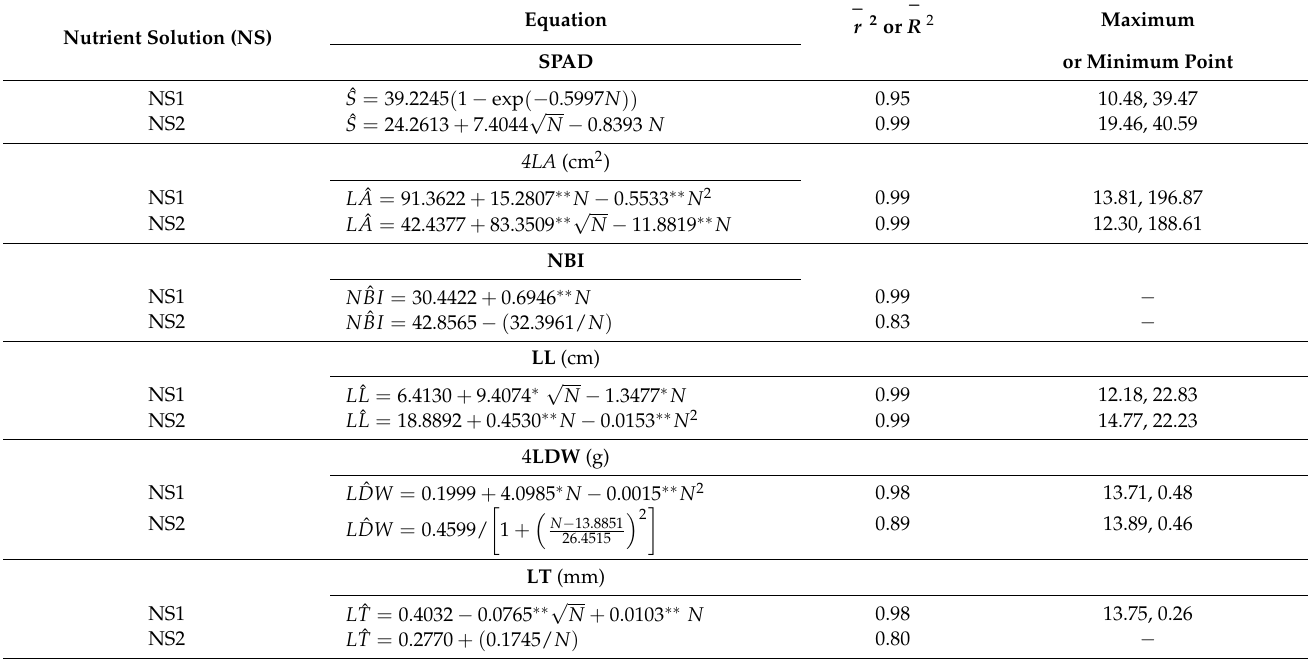
Table 4. Relationship between SPAD (S), leaf area (4LA), nitrogen balance index (NBI), leaf length (LL), leaf dry weight (LDW), and leaf thickness (LT) in the fourth leaf of potato at 21 DAT, and nitrogen concentrations (N) with the estimation of adjusted coefficients of determination ( r 2 or R 2 ) for their nutrient